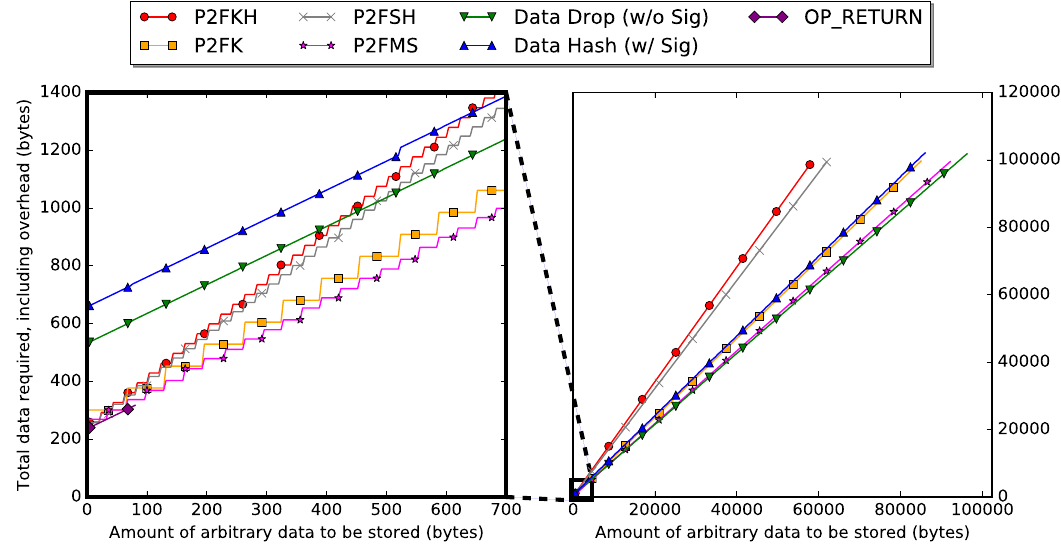
Fig. 5. Currency cost vs. stored data size for small (LEFT) and large (RIGHT) data sizes, up to the maximum size possible within a single transaction. This graph assumes a transaction fee of 20 satoshis/byte and burn values of 1100 satoshis for P2FMS and 546 for other methods requiring